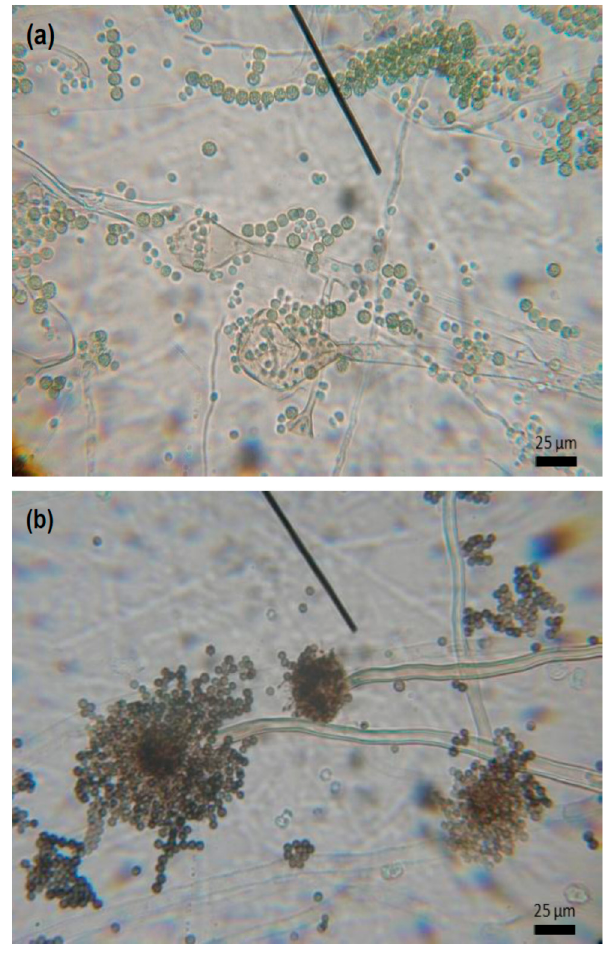
Figure 2. Micrographs of ( a ) Rhizopus sp . ; and ( b ) Aspergillus sp. section Nigri fungi .